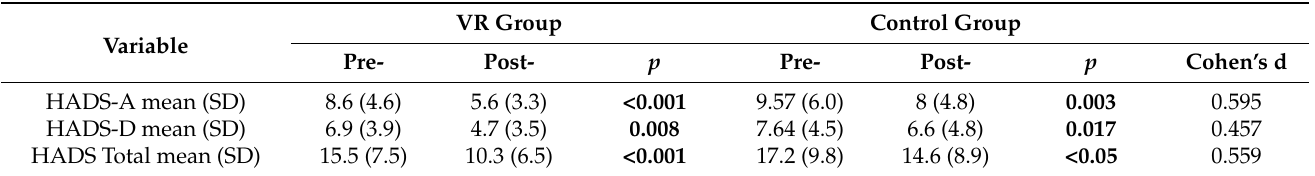
Table 2. Analysis of anxiety and depression.